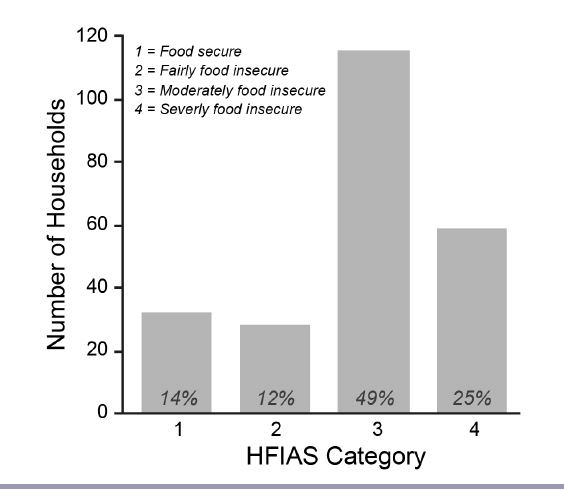
Fig. 2 . Frequency distribution of households in the Access Scale (HFIAS) in Langalanga Lagoon, Solomon